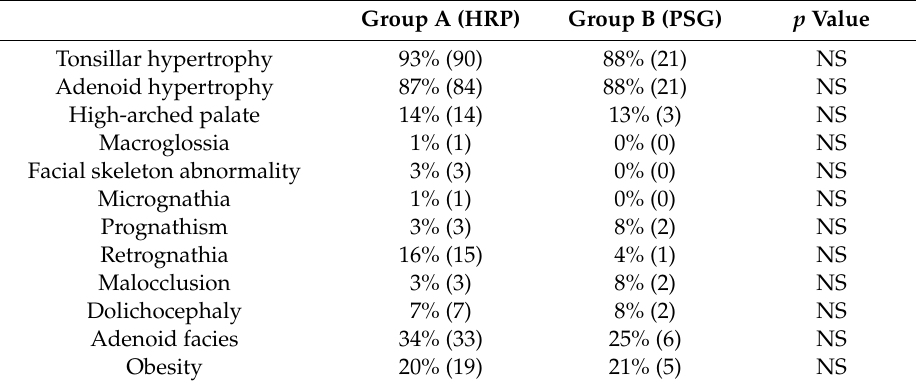
Table 4. Physical examination findings by group.